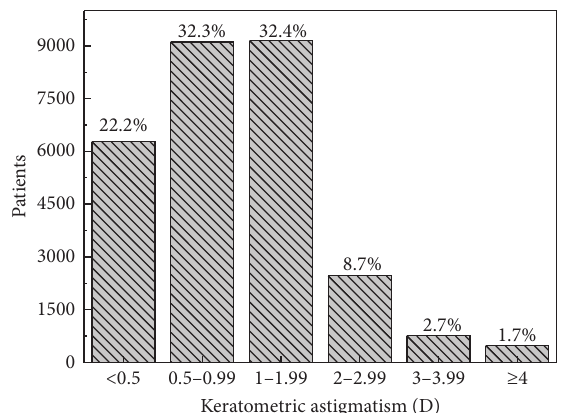
Figure 7: Histogram of the keratometric astigmatism.